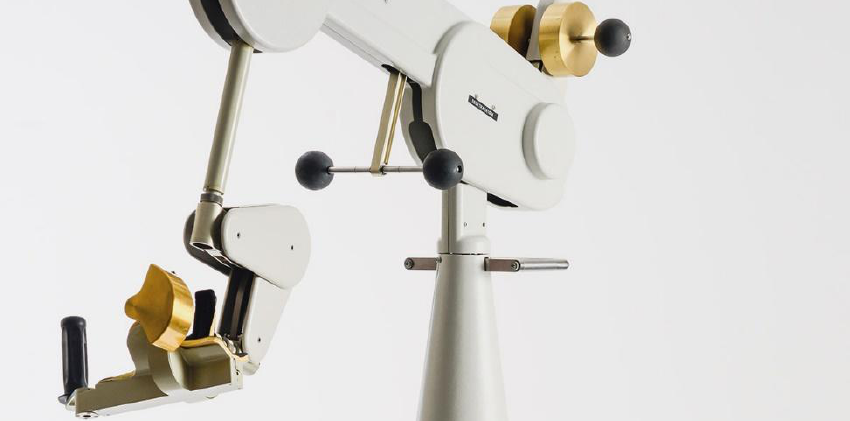
Figure 1. The body of the passive robotic arm called Track-Hold.